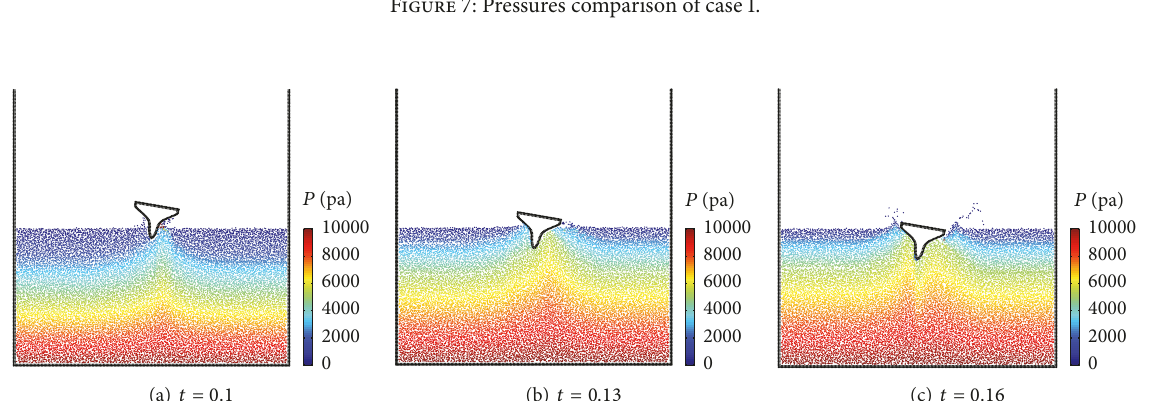
Figure 7: Pressures comparison of case 1.